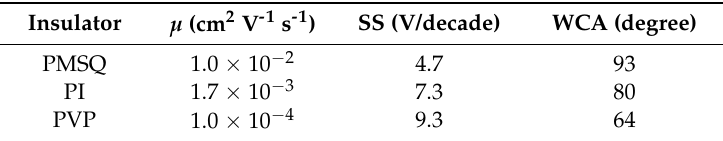
Figure 9. Transfer characteristics of bottom-gate/top-contact P3HT FETs with PMSQ, PI and PVP gate insulators measured at a drain voltage ( V D ) of − 80 V. Table 2. The field-effect mobility ( µ ) and the subthreshold slope (SS) of the bottom-gate/top-contact P3HT FETs with three different polymer gate insulators, together with the water contact angle (WCA) on polymer gate insulators.